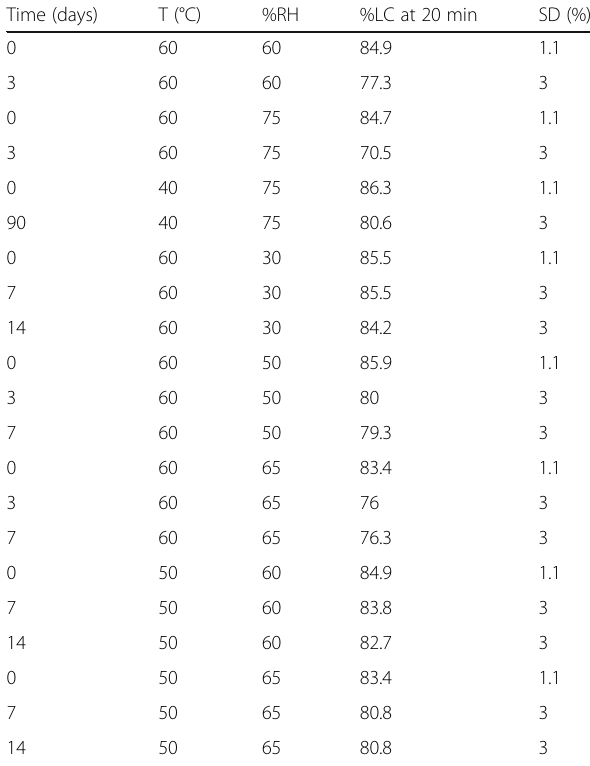
Table 7 ASAP data input for API 2 – dissolution at 20 min